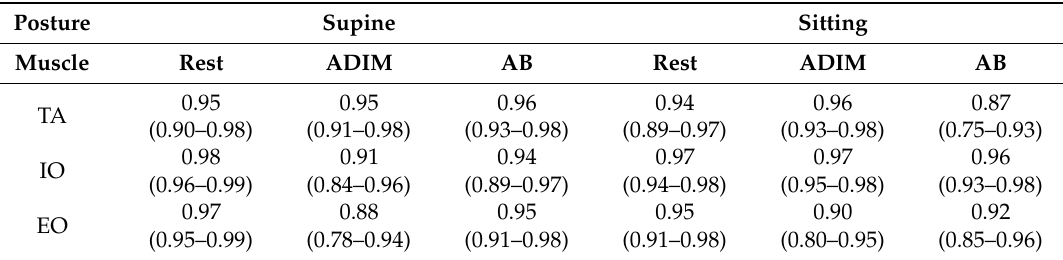
Table 2. Intraclass correlation coe ffi cient (95%